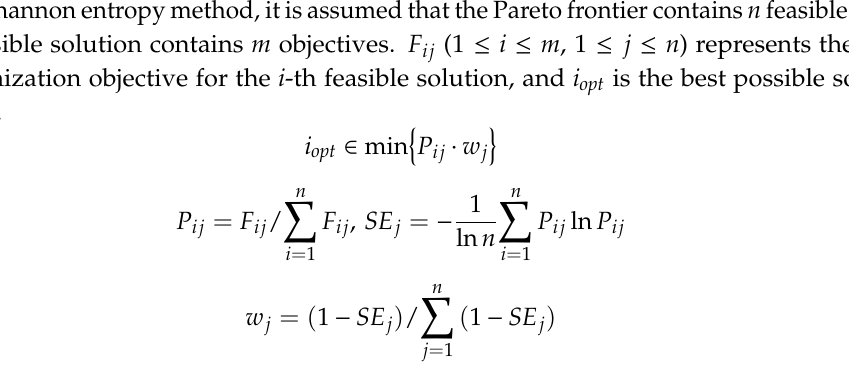
Figure 16. Flowchart of NSGA-II algorithm [40,41,45–51].